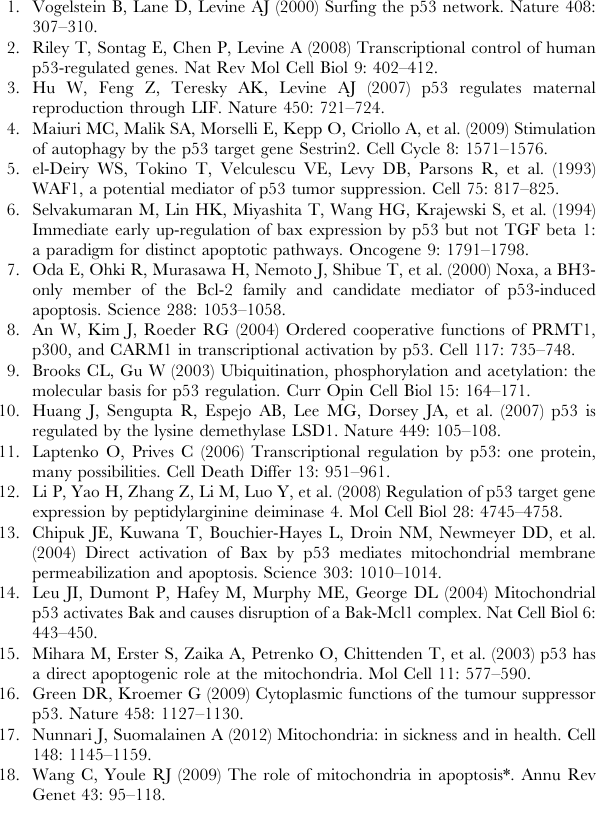
Figure S6 Relative abundance of cytochrome c in pellet and supernatant after p53 or OKL38 incubation. (A) The amount of cytochrome c in the supernatant (upper panel) or in the pellet (lower panel) was detected by Western blot. The relative signal under each treatment condition was measured using the NIH Image J program. With the increased amount of cytochrome c released, a concomitant decrease of cytochrome c from the pellet was detected. (B) The effect of OKL38 on mitochondrial cytochrome c release was tested using an isotonic buffer containing 125 mM KCl and other salts. The amount of cytochrome c in the supernatant or in the pellet (two upper panels) was detected by Western blot. The relative signal was measured using the NIH Image J program. With the increased amount of OKL38, a concomitant increase of cytochrome c release was detected. The amount of OKL38 in the supernatant or the pellet (two lower panels) was also monitored by Western blot. Arrow denotes the recombinant OKL38 detected in the mitochondrial pellet.